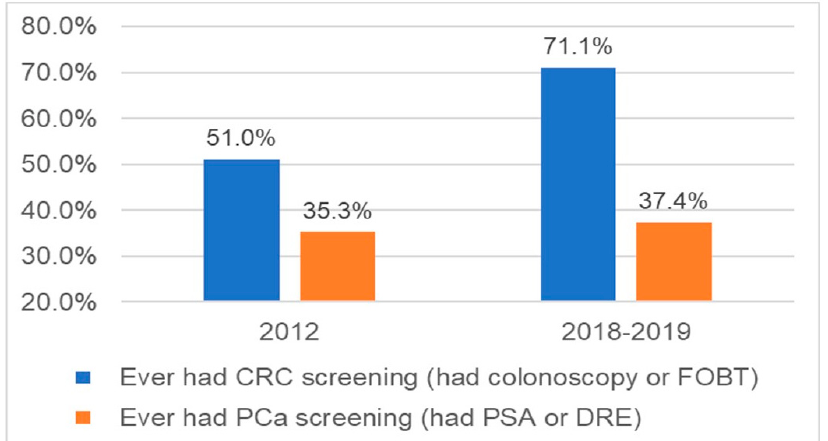
Figure 1. Cancer screening rates among Hopi men in 2012 (Hopi Survey of Cancer and Chronic Disease) and 2018–2019 (current study) survey. Abbreviations: Colorectal Cancer (CRC), Fecal Occult Blood Test (FOBT), Prostate Cancer (PCa), prostate specific antigen (PSA), and digital rectal exam